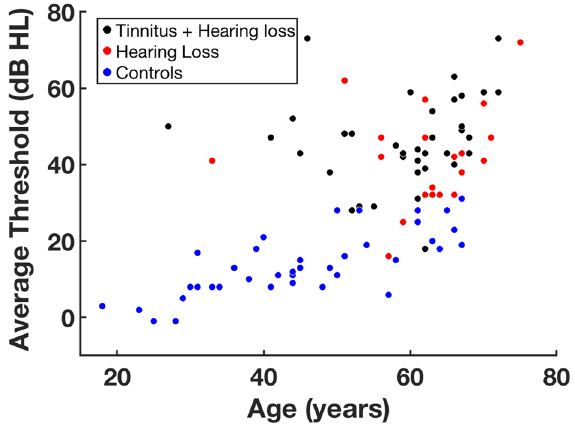
Figure 2. Average hearing threshold of all participants, plotted against age. The control group was significantly younger than both the hearing loss group with (p < 0.0001, t 5.1) and without tinnitus (p < 0.0001, t 5.9). The average threshold was computed for the frequencies of 2, 4, and 8